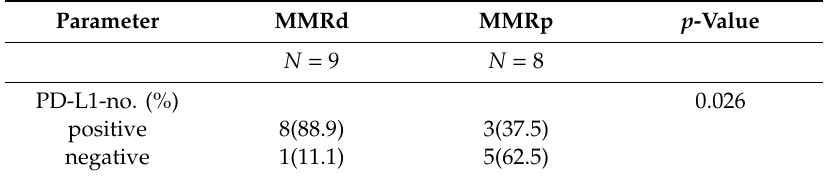
Table 2. Relationship between status of MMR and PD-L1 expression. (undi ff erentiated component).